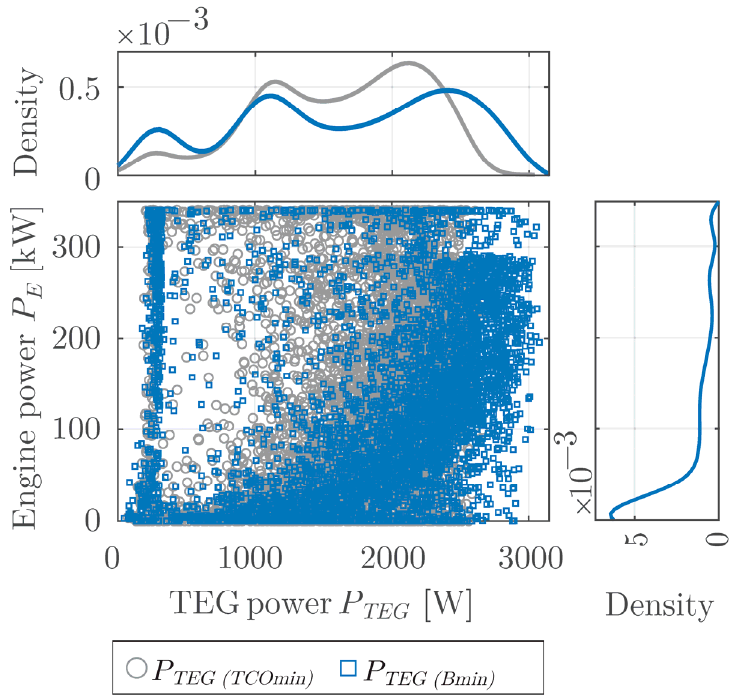
Figure A2. Results of dynamic TEG optimization with different objectives on the SHHS route.